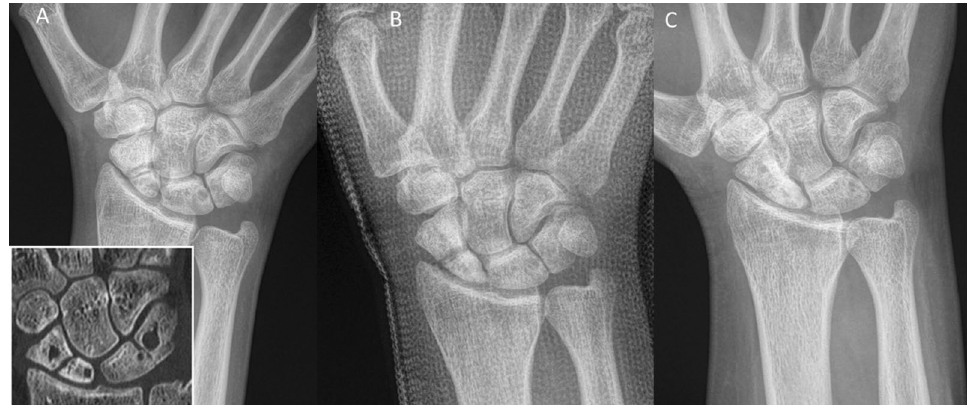
Fig. 6 Example of cysts pre-surgery. Pseudarthrosis patient with a fracture in the middle third. A Pre-surgery. Inset : CT with good visibility of the cysts. B 1-day post-surgery. C 17 months post-surgery; no cysts are